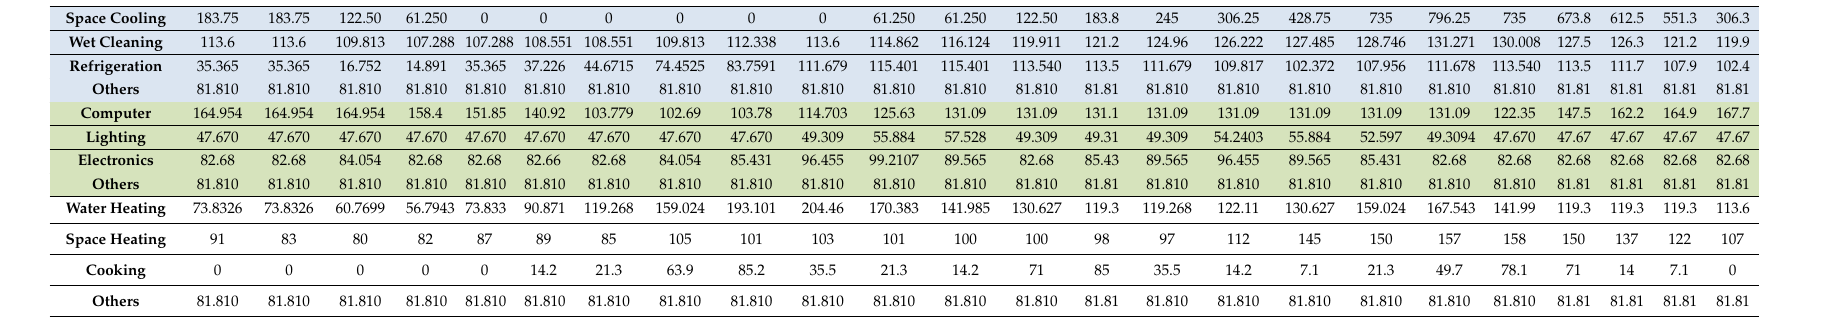
Table 2. Hourly Power Consumption of , and ‘I’ Category Loads in Watts (W) from 00:00 to